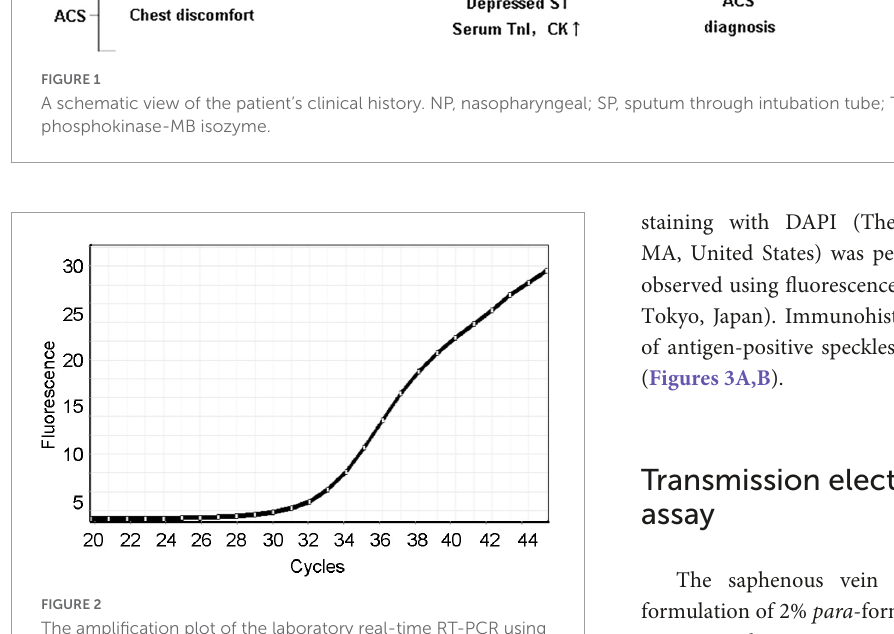
(N_Sarbeco_F1) and GAGGAACGAGAAGAGGCTTG as the reverse primer (N_Sarbeco_R1). The amplification plot is shown in Figure 2